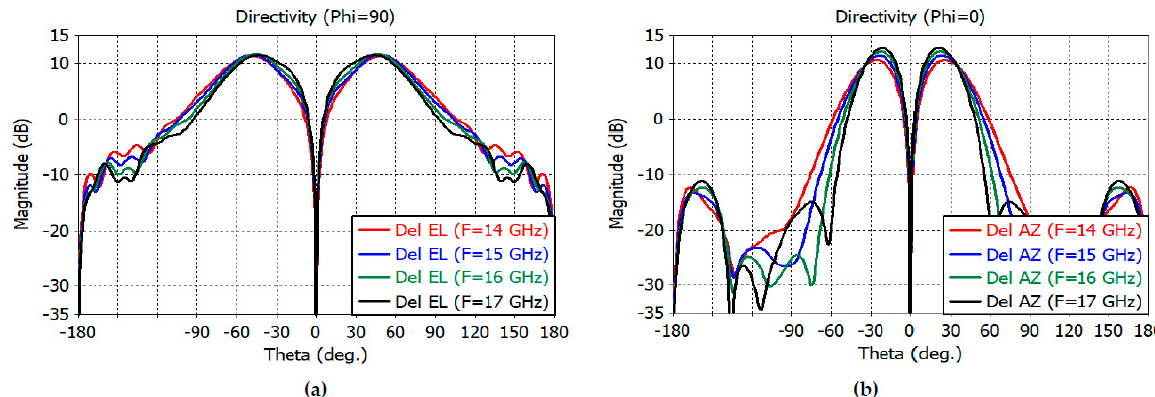
Figure 5. ( a ) Elevation difference channel pattern. ( b ) Azimuth difference channel